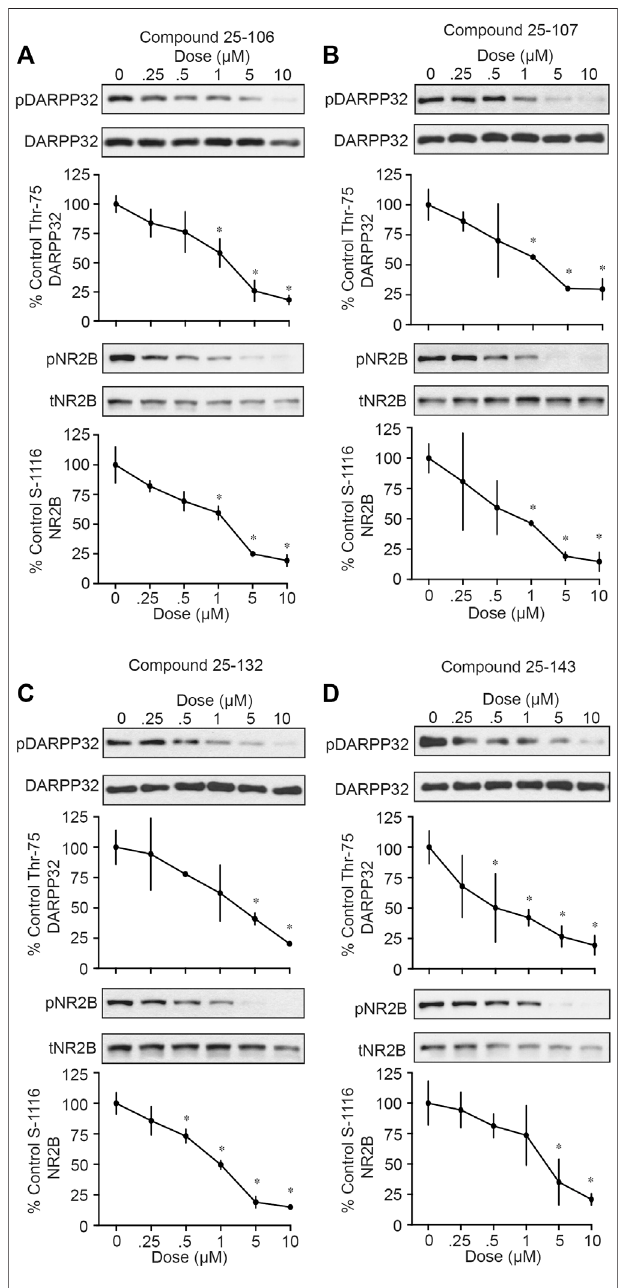
FIGURE2| Invitro testingofCdk5inhibitors.Westernblotforphosphor- DARPP32 (T75) and NR2B (S1116) of acute striatal brain slices treated (1 h) withindicatedconcentrationsof (A) 25 – 106, (B) 25 – 107, (C) 25 – 132,and (D) 25 – 143 ( n = four to six slices per treatment) * p < 0.05 Student ’ s t -test.